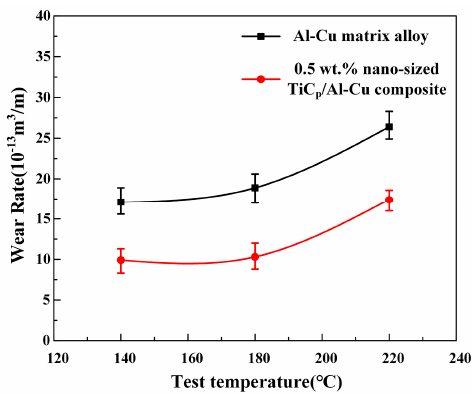
Figure 3. The wear rates of the Al-Cu matrix alloy and 0.5 wt.% nano-sized TiC p /Al-Cu composite at different temperatures.